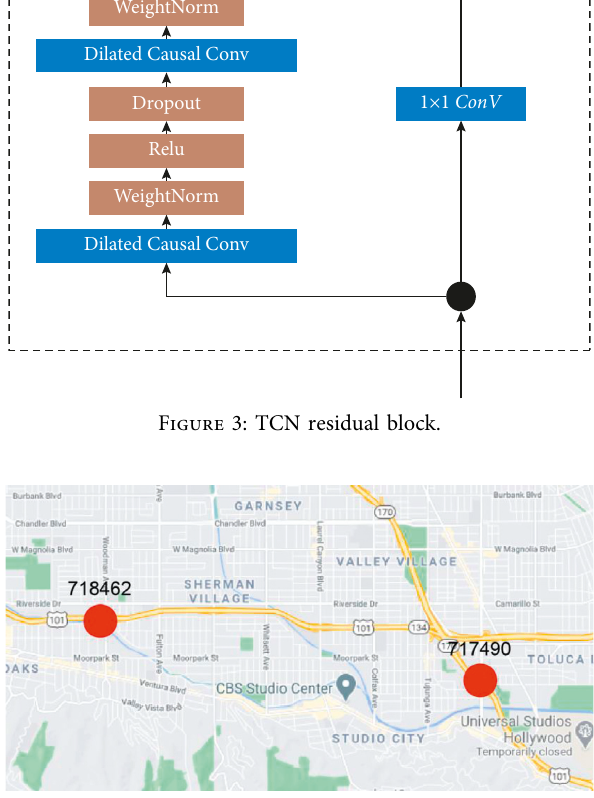
Figure 4: The locations of VDS No. 718462 and VDS No. 717490 for testing.